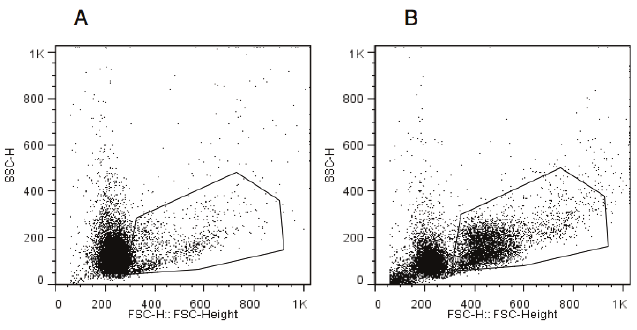
FIGURE 2 - Cytogram representative of synovial cells by flow cytometry. A . Before arthroscopy; B . After